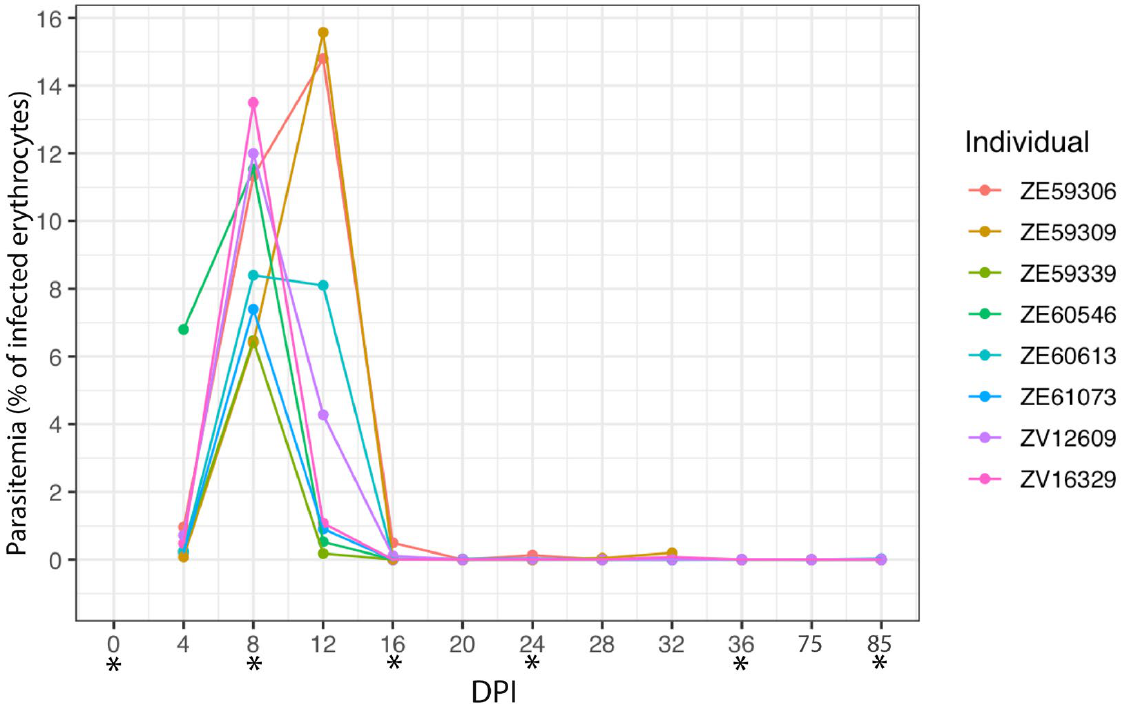
Figure 2. Temporal dynamics of P. homocircumflexum parasitemia. Individual parasitemia values (% of infected erythrocytes) of P. homocircumflexum based on microscopy are presented. * DPI selected for fecal sample collection and microbiome analysis.